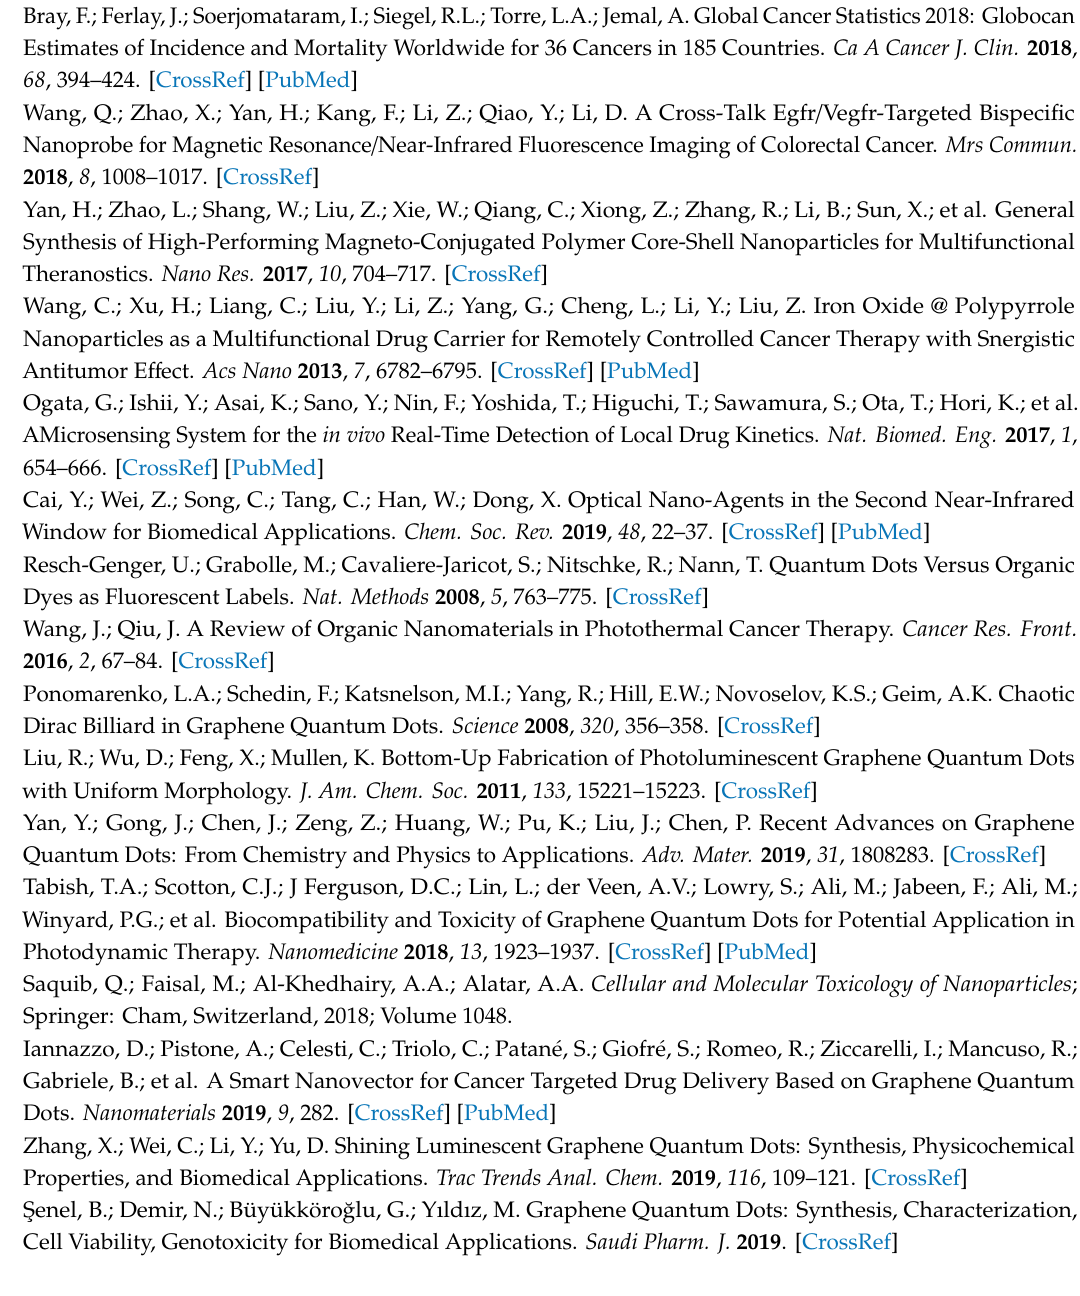
Figure S1: Hydrodynamic size of GQDs-NPs